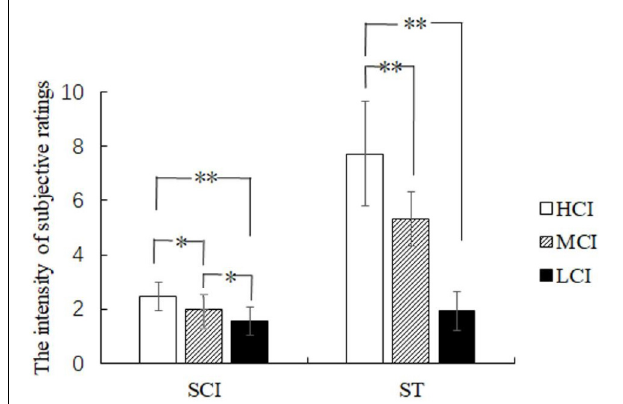
FIGURE 3 | The rating scores of subjective competitive intensity (SCI) and subjective threat (ST). ∗ p < 0.05 and ∗∗ p < 0.01.